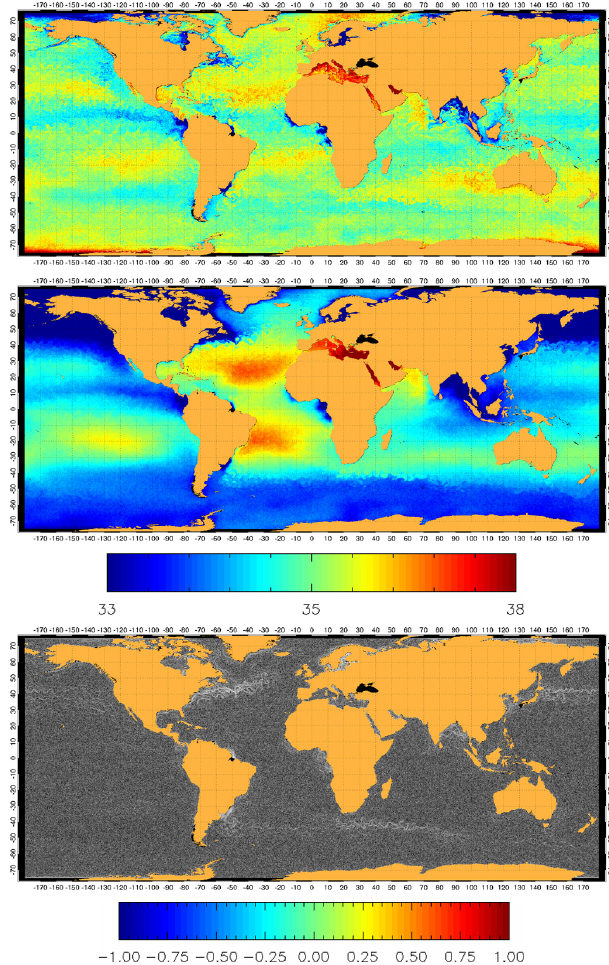
Fig. 7. Top: SSS after the introduction of decorrelated noise with input noise of standard deviation σ i = 1psu. Middle: SSS map af- ter filtering the map on top using the SST map as a template. Bot- tom: Differences between the original (no noise) SSS map and the fused SSS